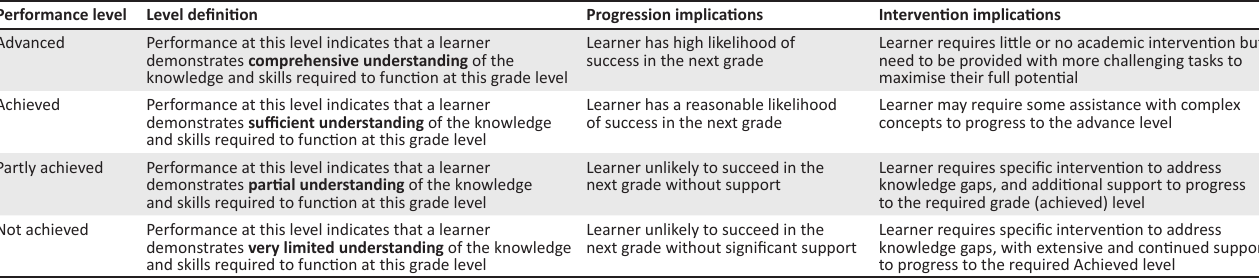
TABLE 1-A1: Performance levels for Grade 6.